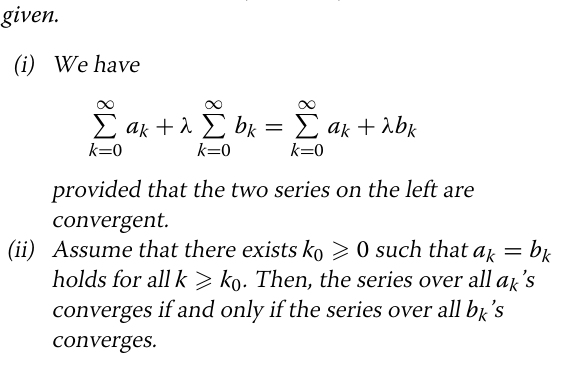
Table 1 Min = 0 and max = 40 for exercises marked by the Table 2 Min = 0 and max = 90 for exercises marked by the teacher and min = 0 and max = 10 for the exercise marked by the teacher and min = 0 and max = 10 for the exercise marked by the students students N M SD N M SD Teacher’s assessment 45 21.09 6.73 Teacher’s Self-assessment 45